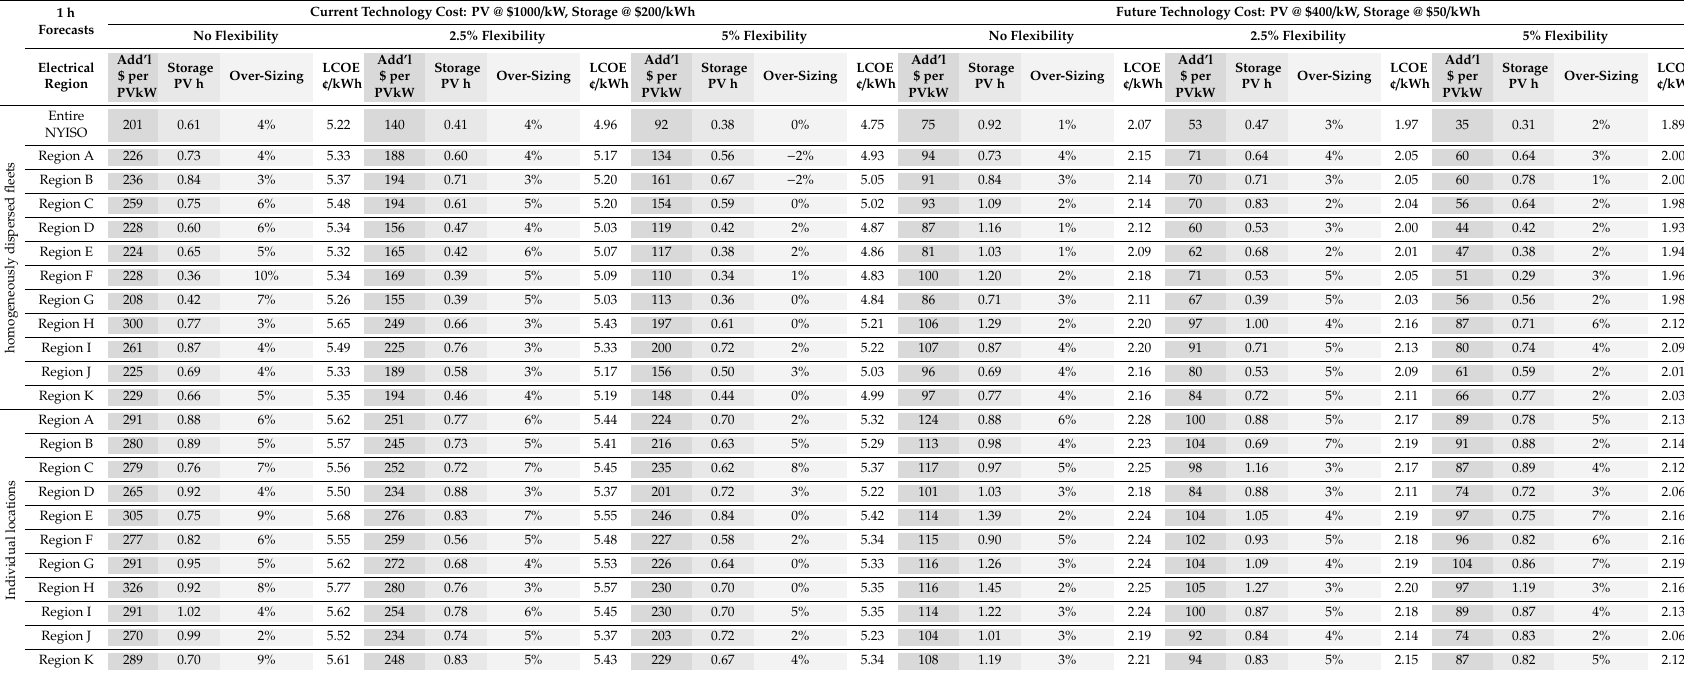
Table A1. One-hour-ahead firm forecast results applying smart